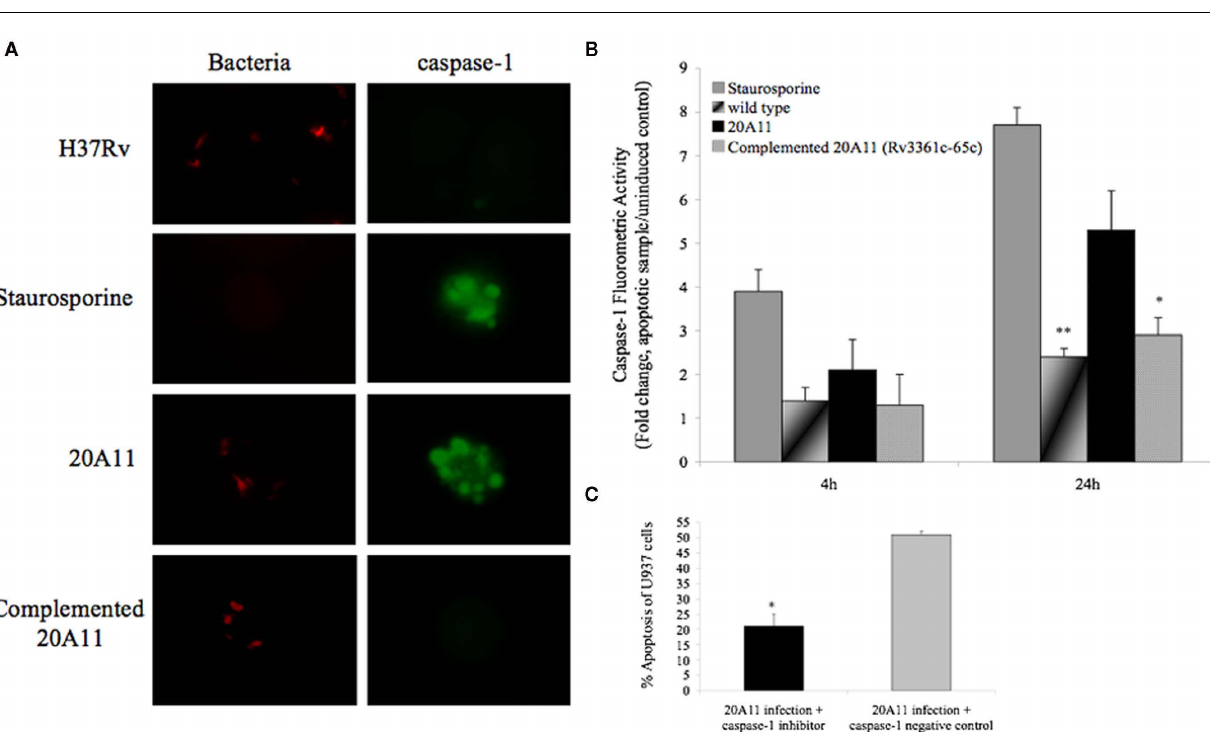
FIGURE 4 | Role of caspase-1-dependent apoptosis. (A) In situ analysis of U937 macrophages for caspase-1 activation during M. tuberculosis H37Rv and 20A11 infection (MOI 10:1).While staurosporine treatment and 20A11 infection triggered caspase-1 activation of macrophages, M. tuberculosis H37Rv and complemented 20A11 clone were able to suppress caspase-1 activation. Bar, 10 μ m. (B) M. tuberculosis infection prevents caspase-1 activation in macrophages. Cells were infected with wild-type or mutant strains, and fold change of caspase-1 activation was calculated according the manufacturer’s protocol.The data represent the average of three independent